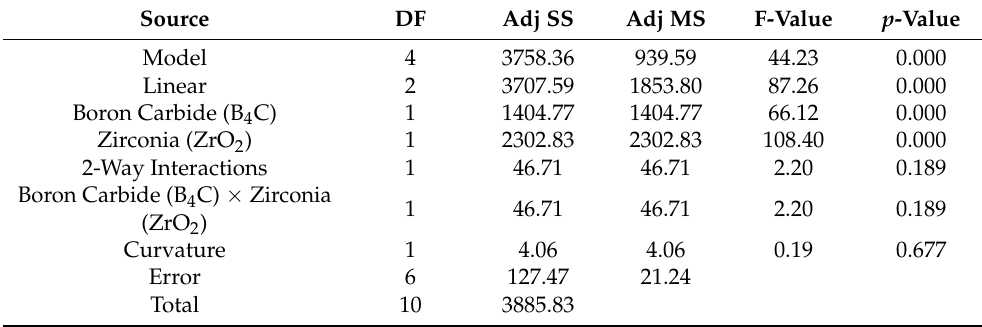
Table 3. Compressive-strength analysis of variance by DOE.